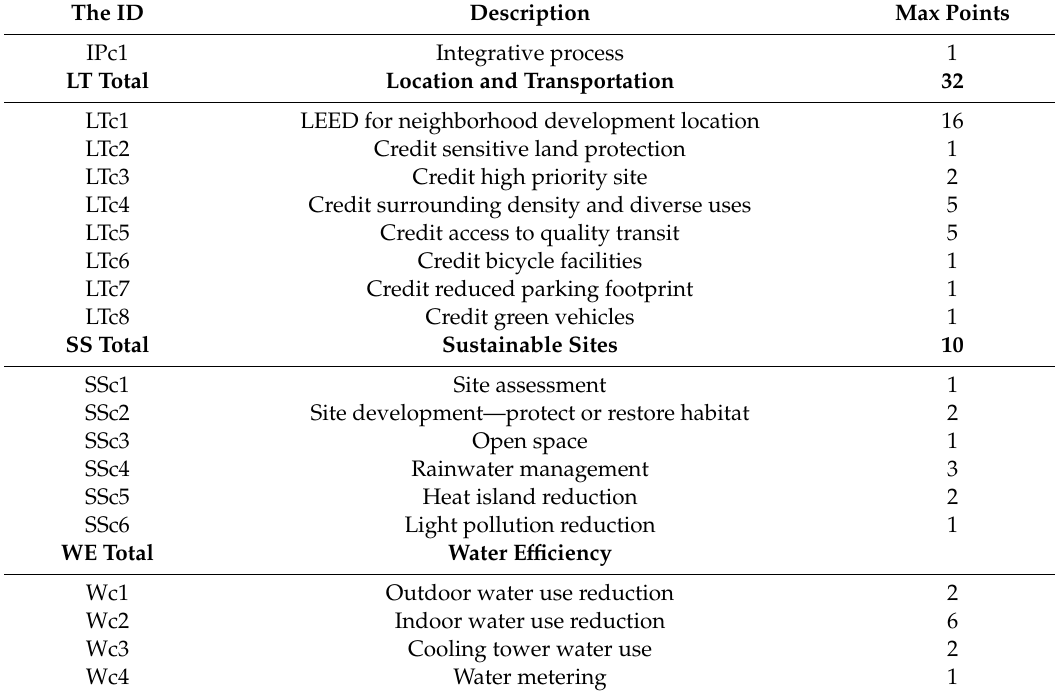
Table A1. Rating Systems: LEED BD + C: Building Design and Construction. Source: https: // leeduser. buildinggreen.com /